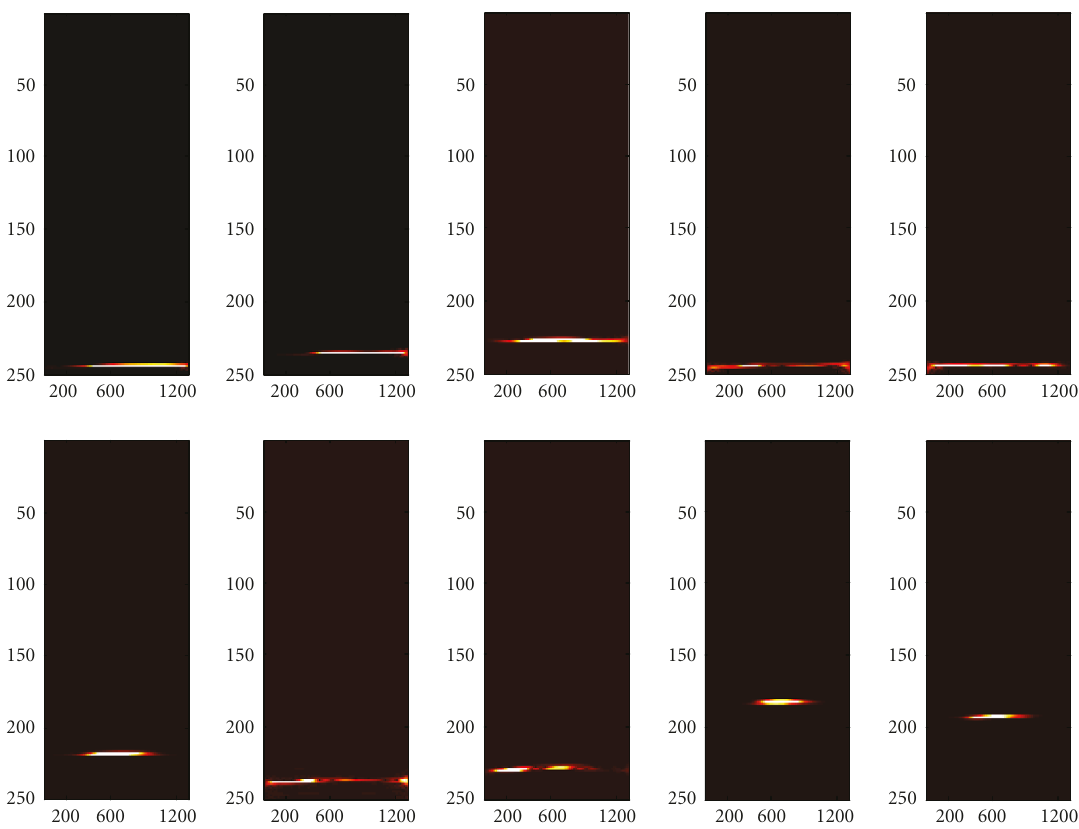
Figure 4: The formants components isolated by using the eigenvalues decomposition